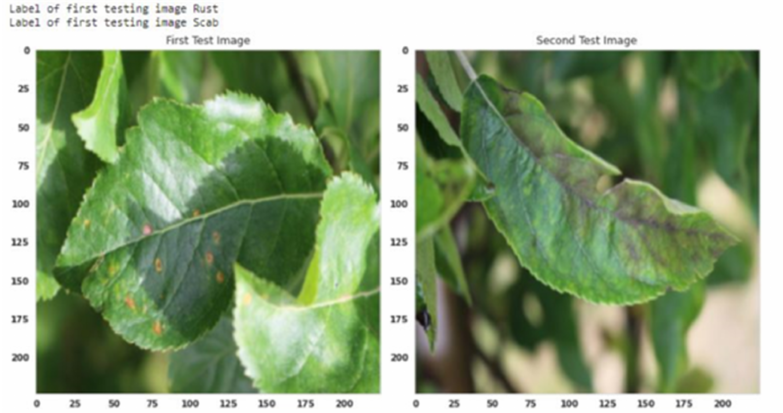
Figure 13. Example of the tested pictures that correctly classified.